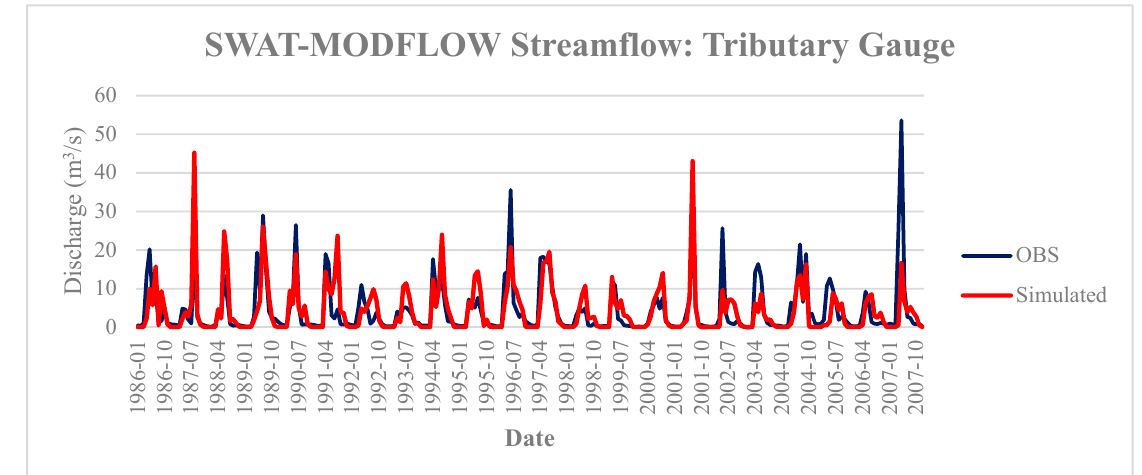
Figure A4. Comparison of simulated SWAT–MODFLOW results to observed values at the Little Smoky River watershed tributary gauge.